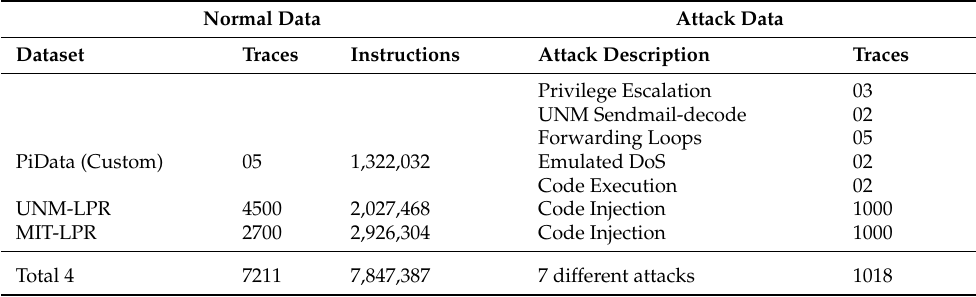
Table 2. Syscall datasets details: Custom-PiData is our laboratory-generated dataset, and UNM Sendmail and UNM-LPR are public datasets. Column normal data provides details of traces and the number of instructions in each dataset, the column attack provides names of the attacks and the number of traces for each attack. Normal Data Attack Data Dataset